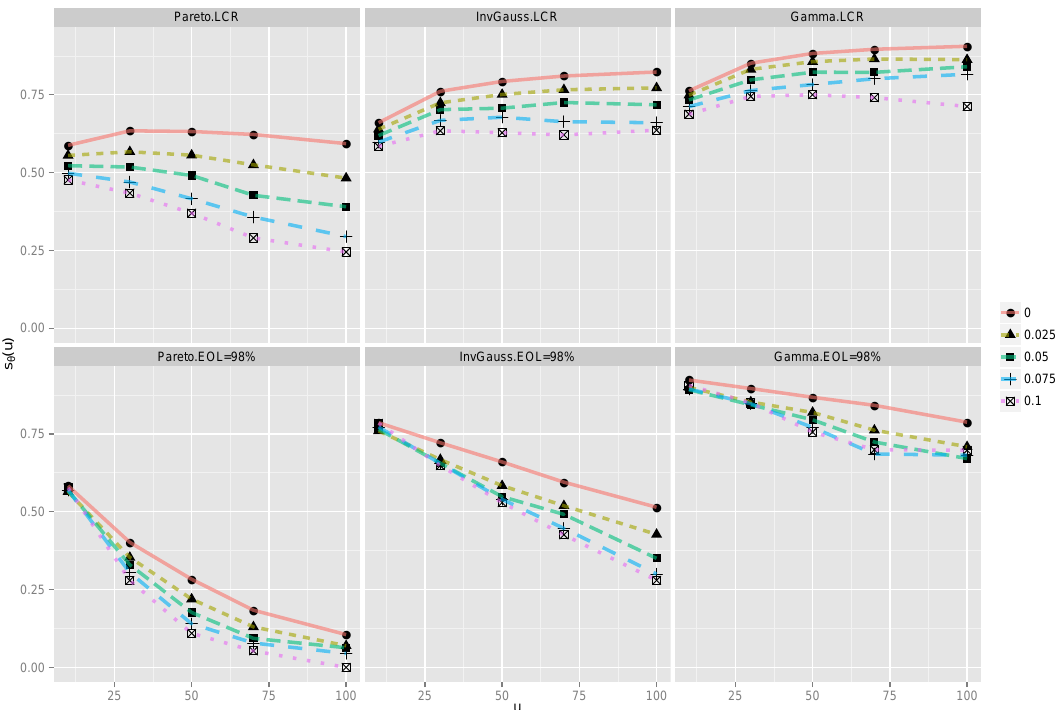
Figure 7. s θ ( u ) (from (34), obtained by approximation at T = 13,800) is the ratio of the standard deviation of the dividend income obtained under reinsurance, to that without (infinite horizon case). For Pareto, Inverse Gaussian and Gamma claim distributions, initial reserve levels u = 10, 30, 50, 70, 100, time value of money ρ = 0.0005, and safety loadings θ = 0, 0.025, 0.05, 0.075, 0.1. Top panel: LCR; bottom panel, EOL, with L taken as the 98th percentile of the claims distribution. Simulations are done with N = 10,000 sample